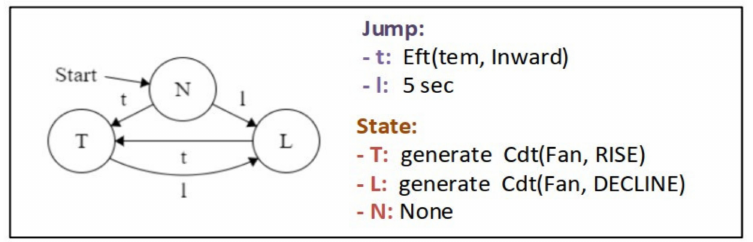
Figure 3. Example of middle EPA with boundary conditions triggering